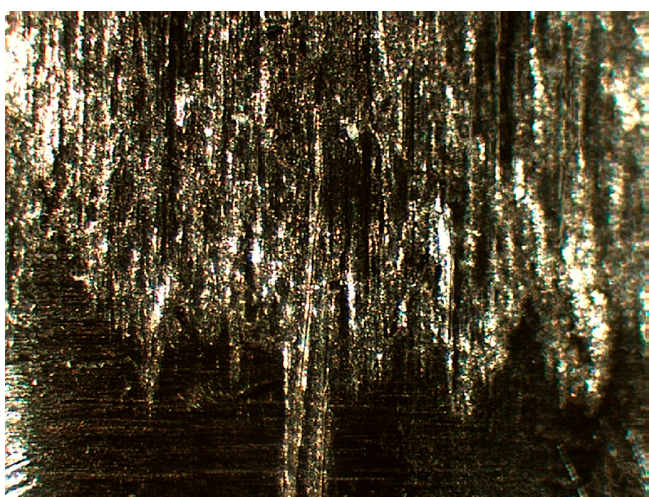
Figure 5. Section of the surface of a primary crown following a number of load ‐ change cycles. In the lower part of the picture, residues of the horizontal processing of the initial condition can be seen. The vertical signs of wear have been portrayed more clearly in the upper half of the picture (enlargement 63:1).